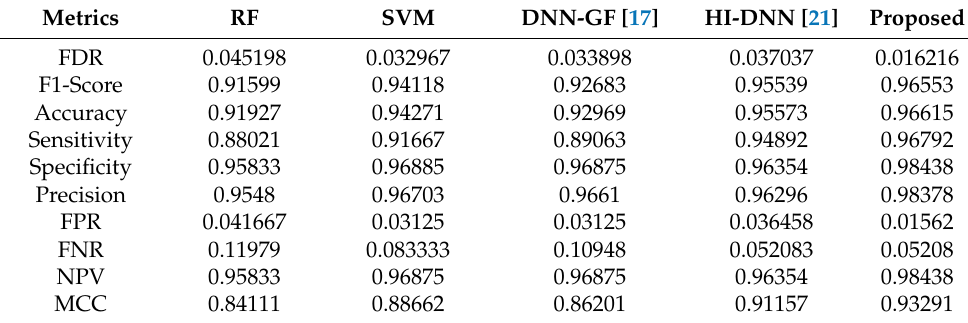
Figure 8. Graphical representation of the proposed model. Table 5. Classification results with segmentation.